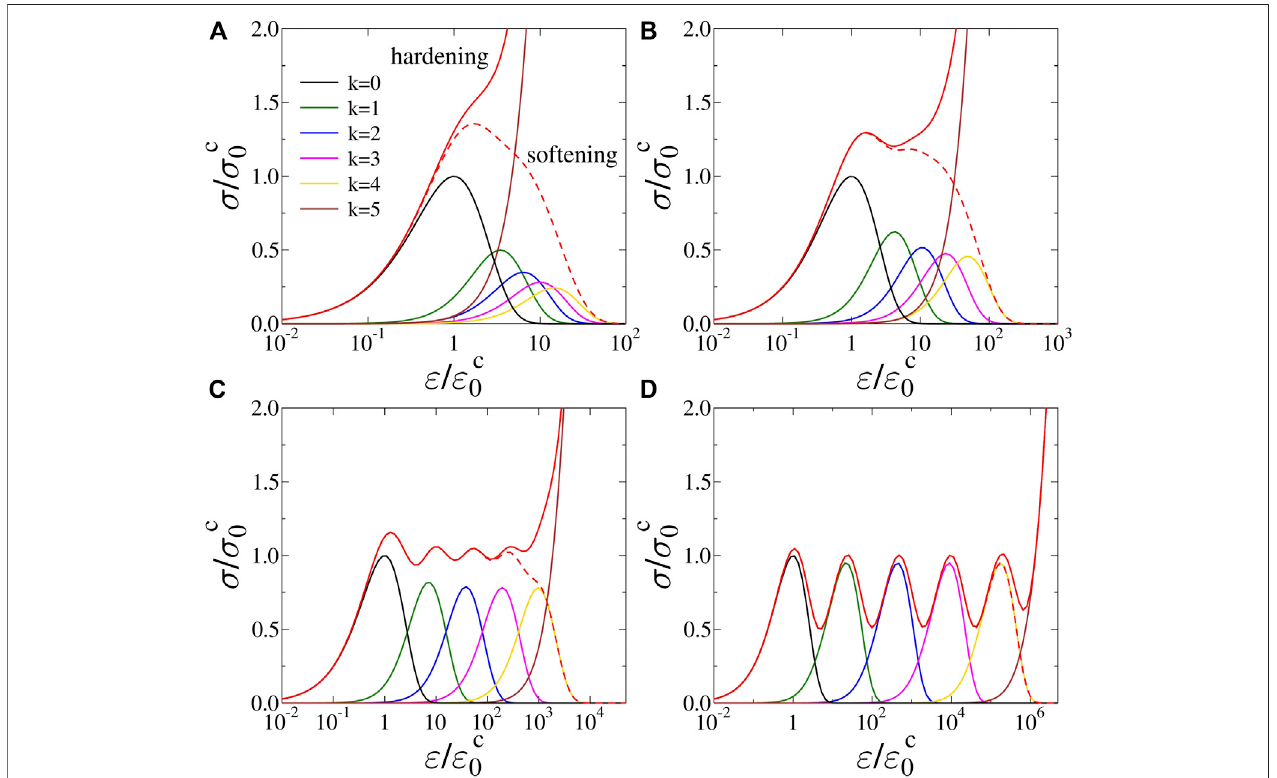
FIGURE 4 | Emergence of the plateau regime as the stiffness parameter a decreases at a fi xed value of the maximum number K (cid:1) 5 of stick-slip cycles allowed for fi bers.Thepartialloads σ ( ε ) Eqs9 – 11 keptbythesubsetsof fi berswhichhavesufferedexactly k slipeventsarealsoshownfor k (cid:1) 0 , 1 , 2 , 3 , 4 , 5forfourdifferentvalues k of the stiffness parameter a : (A) 0.8, (B) 0.5, (C) 0.2, and (D) 0.05. The constitutive curve of the entire bundle σ ( ε ) is also presented for both hardening (continuous red line), and softening (dashed red line). On the horizontal axis logarithmic scale is used due to the large strains involved at low a